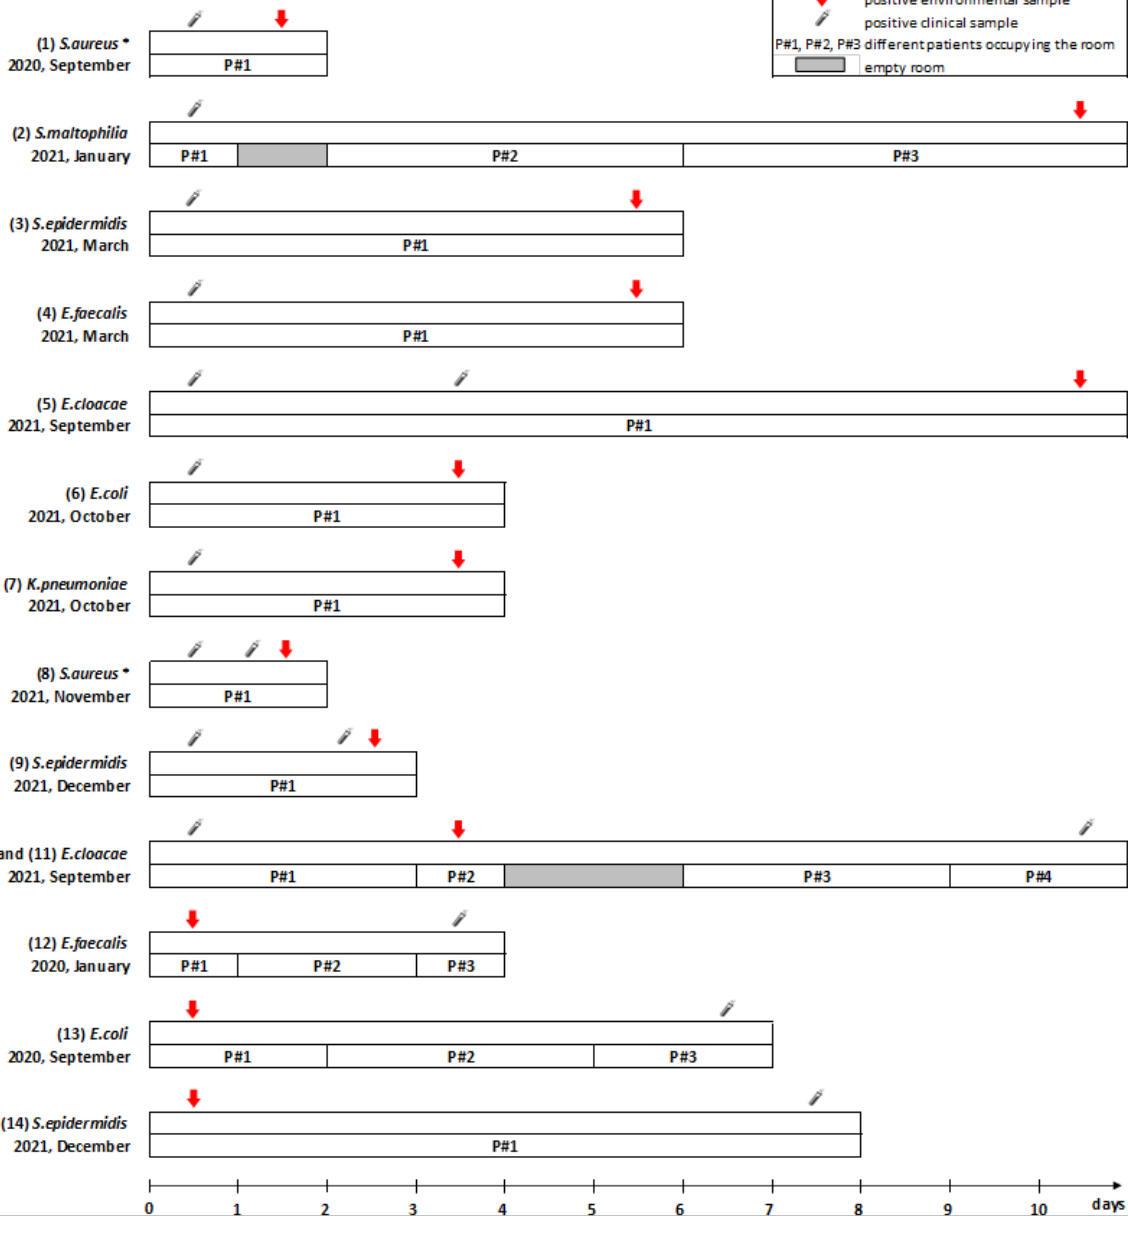
Figure 3. Synoptic representation of the cases of potential contamination ( n = 14). Symbols are explained in the upper right legend (*: bacteria of interest); episodes 10 and 11 represent two potential cross-contaminations of the same bacterium from P#1 to environment and from environment to